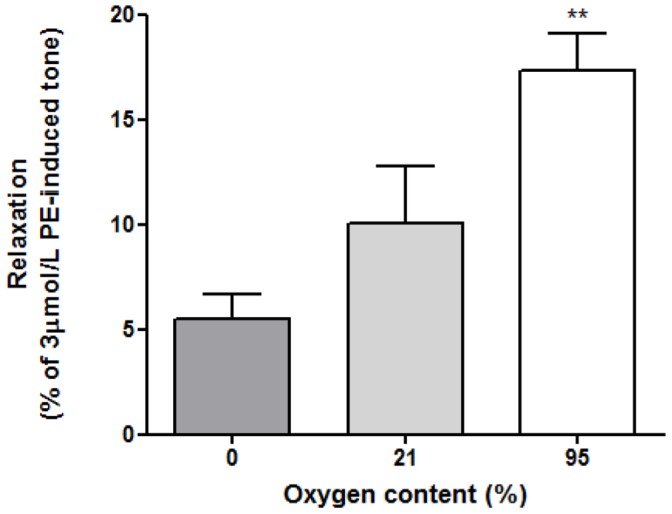
The influence of eNOS inhibitor, LNMMA, upon O2-mediated relaxation.LNMMA had no effect on the relaxation responses. Similarly to Figure 3, 95% oxygenated buffer samples generated the greatest relaxation compared with 0% O2 samples (all n = 4, **p<0.01 cf. 0% O2).